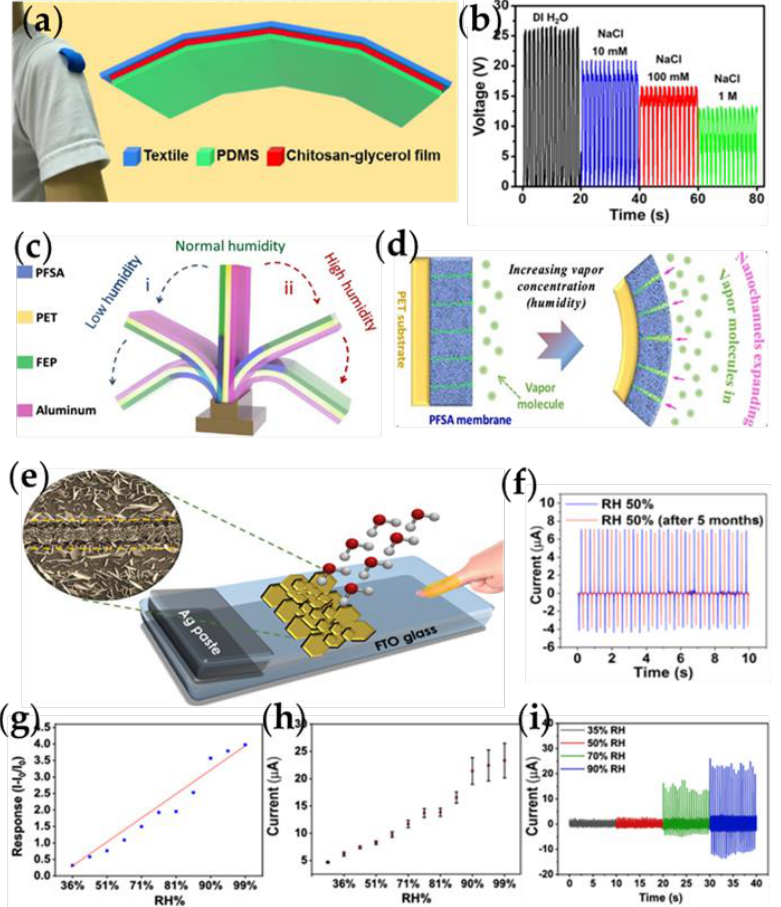
Figure 5. ( a ) Components of the self-powered sweat sensor. ( b ) The output voltage of the self-powered sweat sensor when detecting clothes worn with various concentrations of NaCl solution adsorbed [74]. Copyright 2018, ELSEVIER. ( c ) Schematic illustration of the humidity-responsive TENG based on the moisture/vapor-driven smart material (PFSA). ( d ) Deformation mechanism of the TENG blade in response to changed humidity [75]. Copyright 2019, AMER CHEMICAL SOC. ( e ) Schematic diagram of a self-powered dynamic response humidity sensor based on SnS 2 . ( f ) Current increases by varying the level of RH from 30 to 99% at room temperature, ( g ) sensor response by increasing RH at room temperature, ( h ) Dynamic responses of the self-powered SnS 2 -based humidity sensor by exposing to different RH based on TENG source power ( i ) Stability of sensor responses to 50% humidity over 5 months [76]. Copyright 2022, AMER CHEMICAL